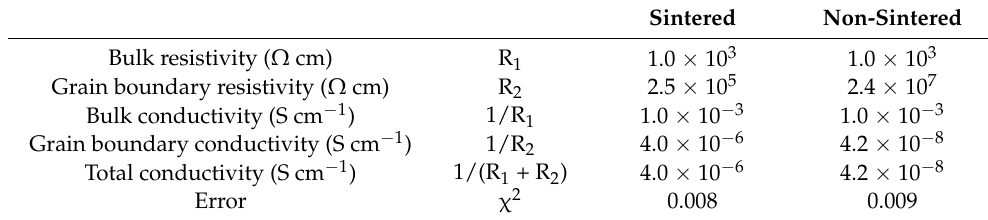
Figure 5. Equivalent circuit proposed to model the ionic conductivity process in La 0.5 Li 0.5 TiO 3 . Table 2. Bulk and grain boundary resistivity and conductivity for sintered and non-sintered La 0.5 Li 0.5 TiO 3 .